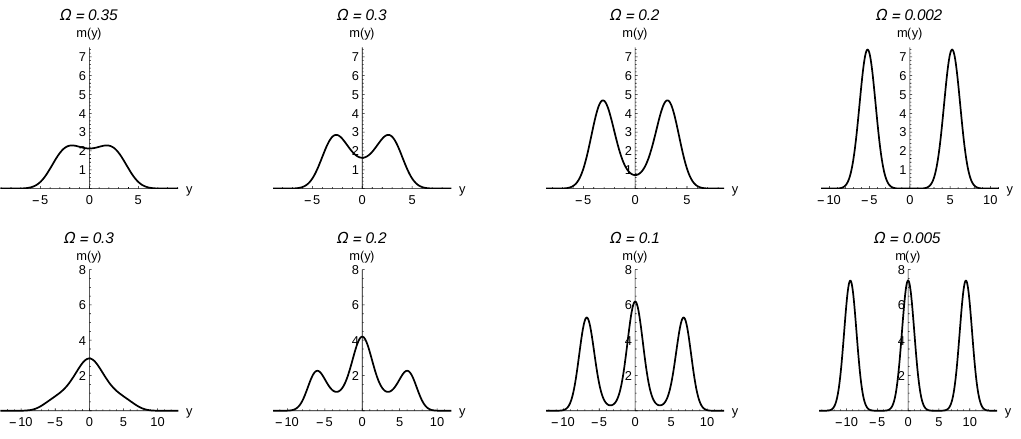
Figure 12 . Deformed black bars corresponding to N = 4 ; 6 (dumbbells) for di(cid:11)erent values of (cid:10). The deformation only shows y -dependence and the dumbbells remain Gaussian in x